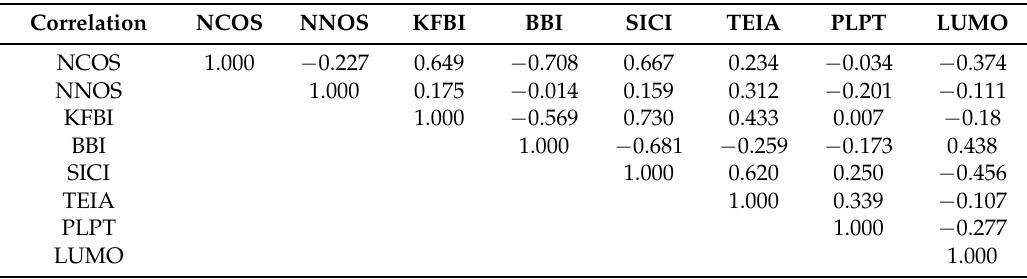
Table 3. The correlation of eight